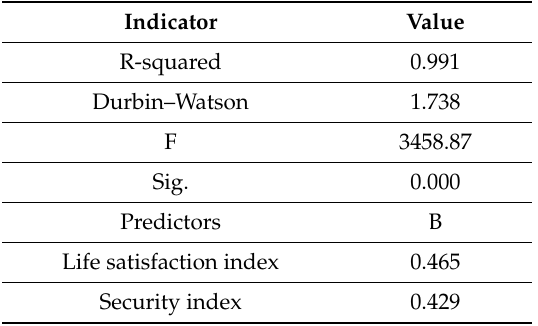
Table A2. Regression model A. Dependent variable: financial